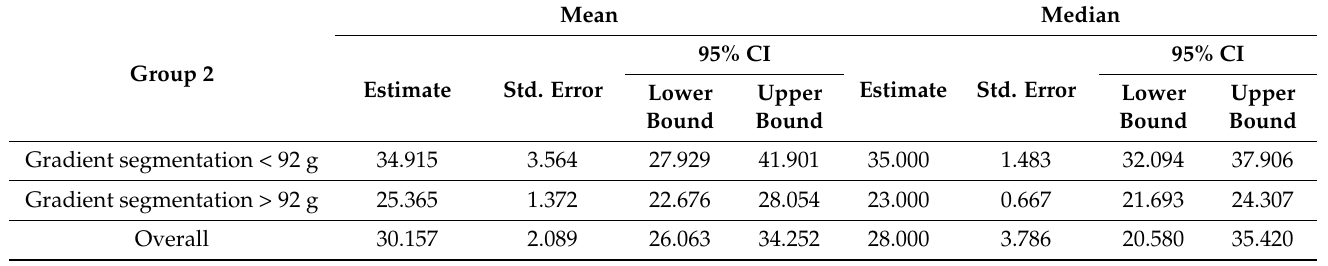
Table 4. Survival time means and medians.